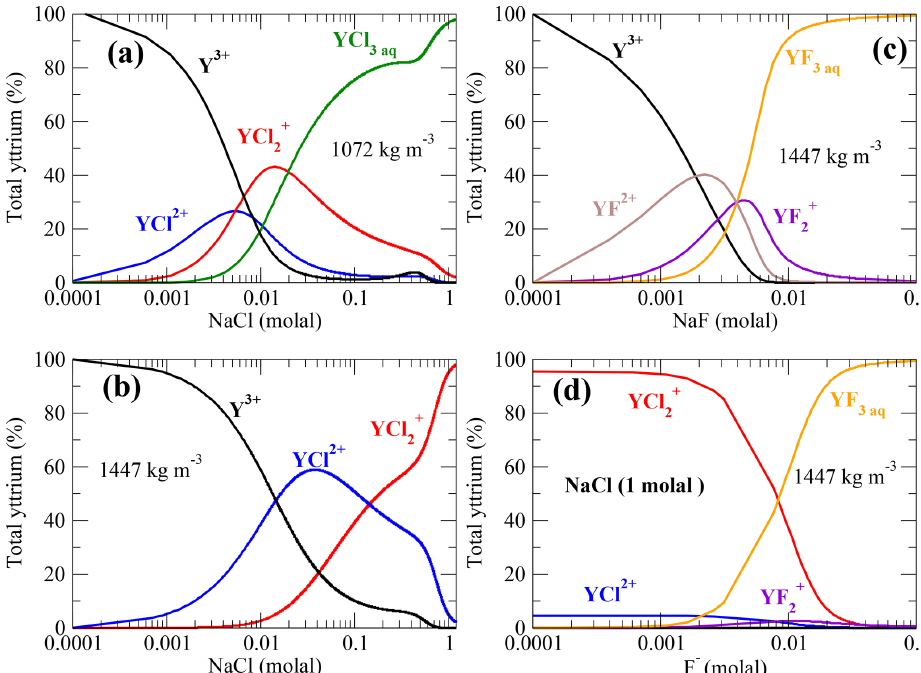
Figure 12. Y–chloride and Y–fluoride species distribution computed from the AIMD data assuming 23ppm dissolved yttrium in aqueous solution at 800 ◦ C. (a, b) Y–chloride species distribution versus the logarithmic sodium chloride concentration in low- and high-density fluid; (c) Y–fluoride species versus the amount of dissolved NaF and (d) Y − Cl / F species in a 1molal NaCl solution with increasing F − concentration. The pH of the solutions is changing in a range of ± 1 . 7 over the concentration